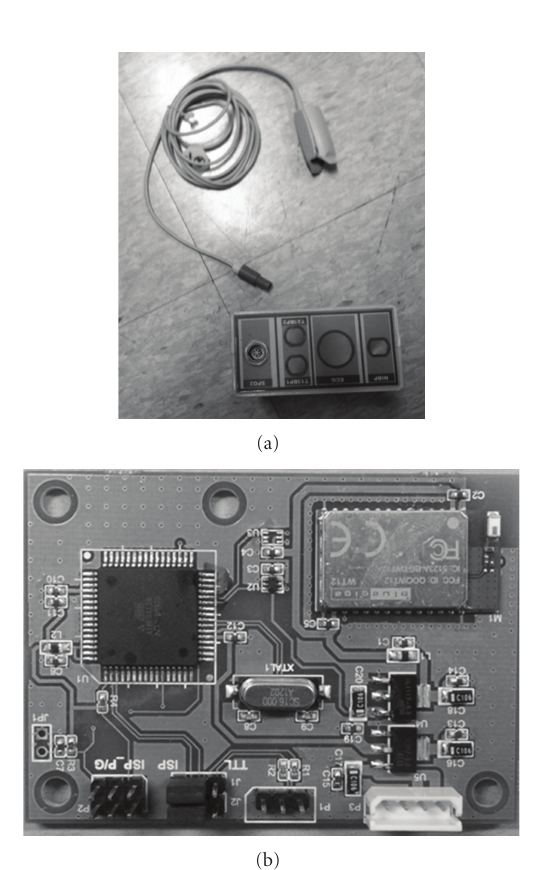
Figure 6: The prototype of the pulse oximeter. loaded with ATmega 128-16AC MCU and a Bluegiga WT12 Bluetooth module.